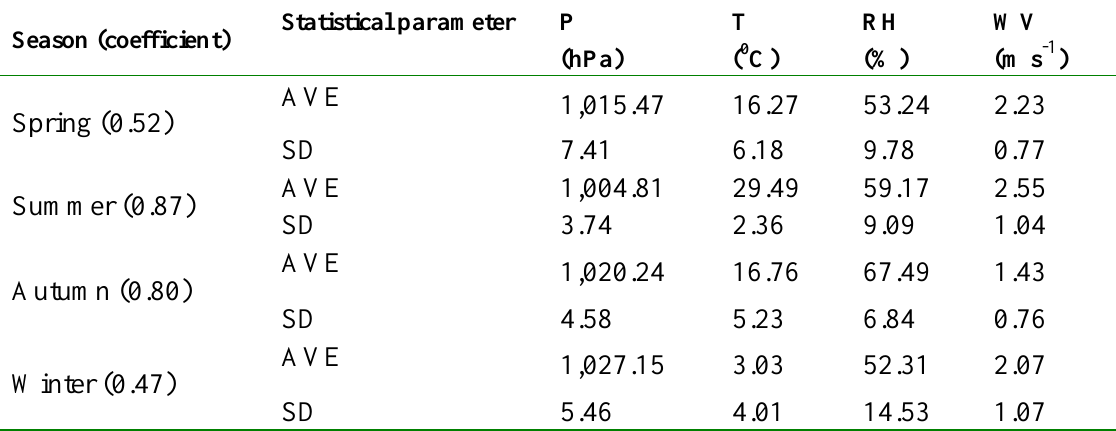
Table 1. Correlation between PM meteorological